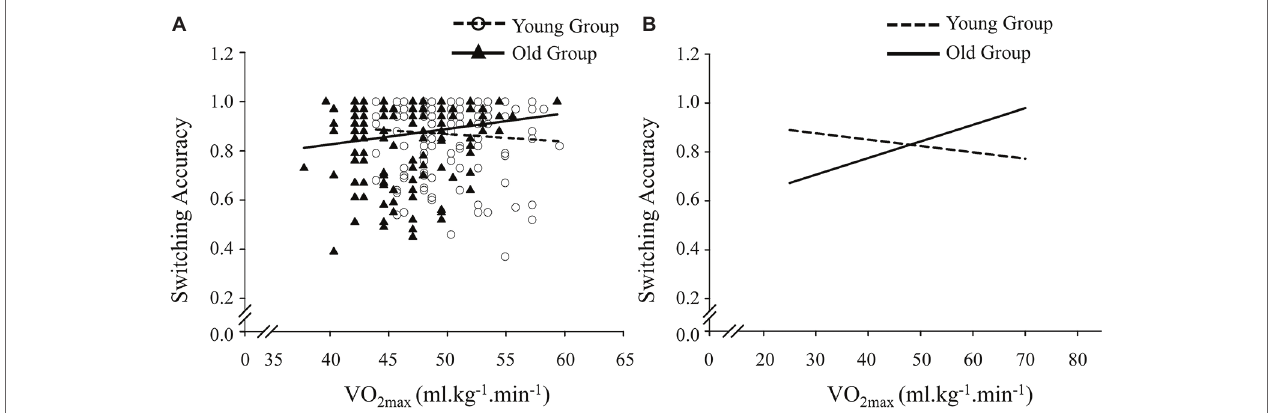
FIGURE 1 | Scatterplots of the relationships between cardiorespiratory fitness (i.e., VO 2max ) and switching accuracy of the Local-Global task. (A) Raw data and (B) data that adjusted within the regression